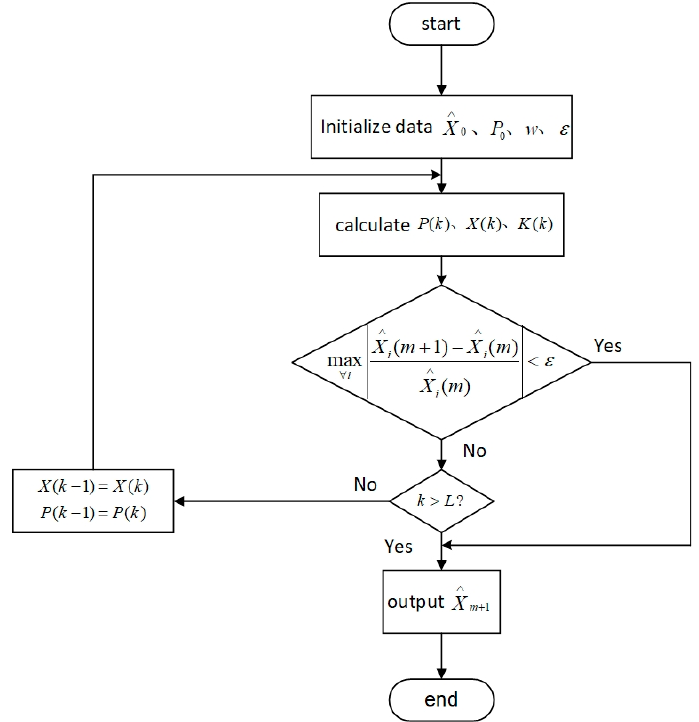
Figure 6. Flow chart of the weighted recursive least-squares algorithm.